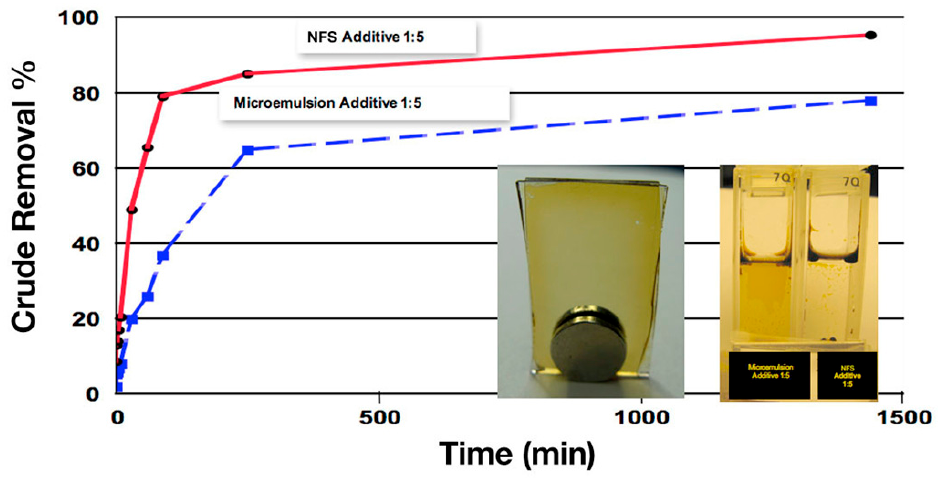
Figure 12. Dynamics of the microemulsion additive and NSF additive in removing crude oil from the 2D glass pores.